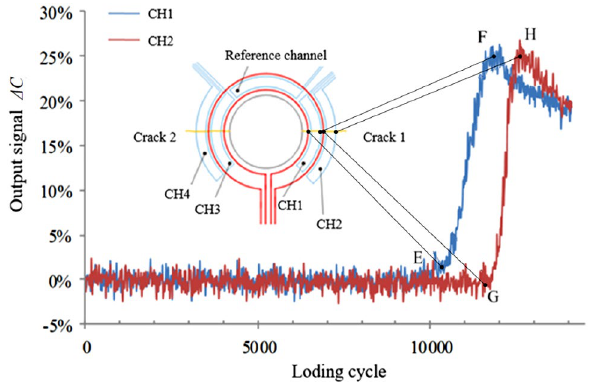
Figure 2. The relation between the crack length and output signals of the sensor.